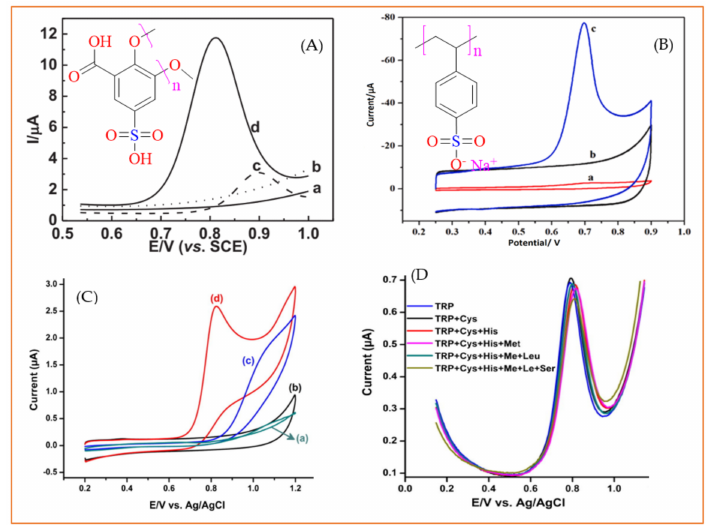
Figure 10. ( A ) Differential pulse voltammograms of the bare GCE (a,c) poly(sulphosalicylic